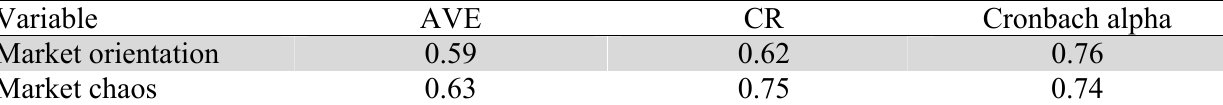
The results of AVE, CR and Cronbach